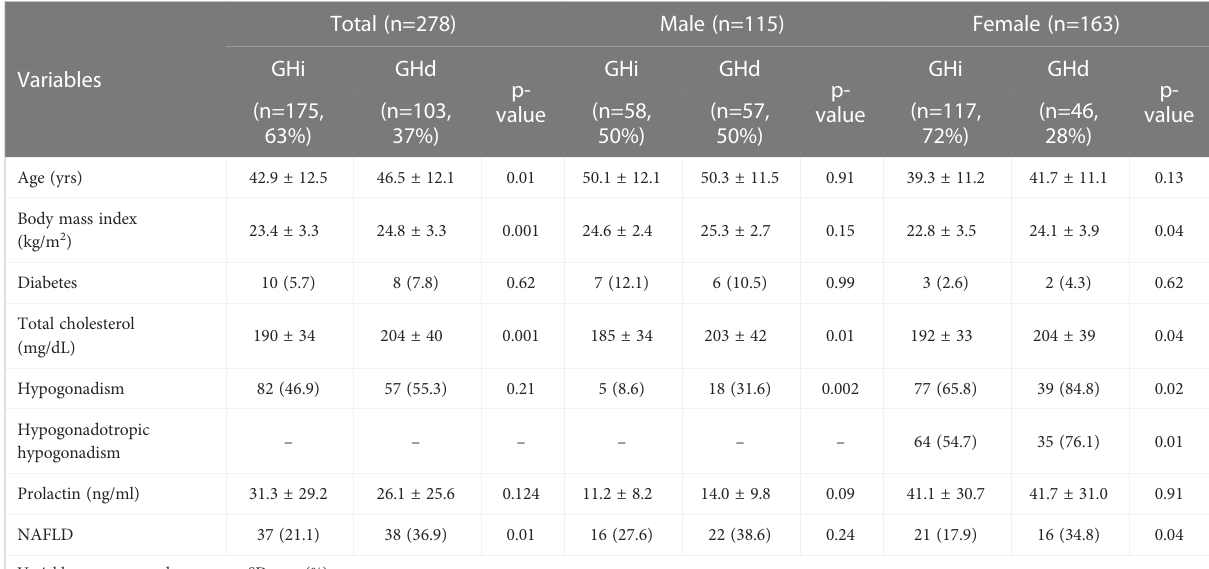
TABLE 1 Basic characteristics of